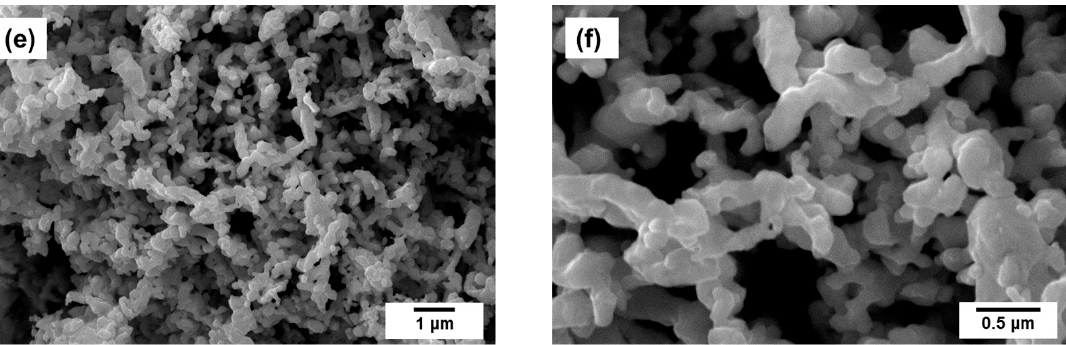
Figure 2. SEM images of the as-prepared Pt 1 − x Ni x alloys: ( a , b ) Pt 0.70 Ni 0.30 ; ( c , d ) Pt 0.50 Ni 0.50 ; ( e , f ) Pt 0.10 Ni 0.90 .